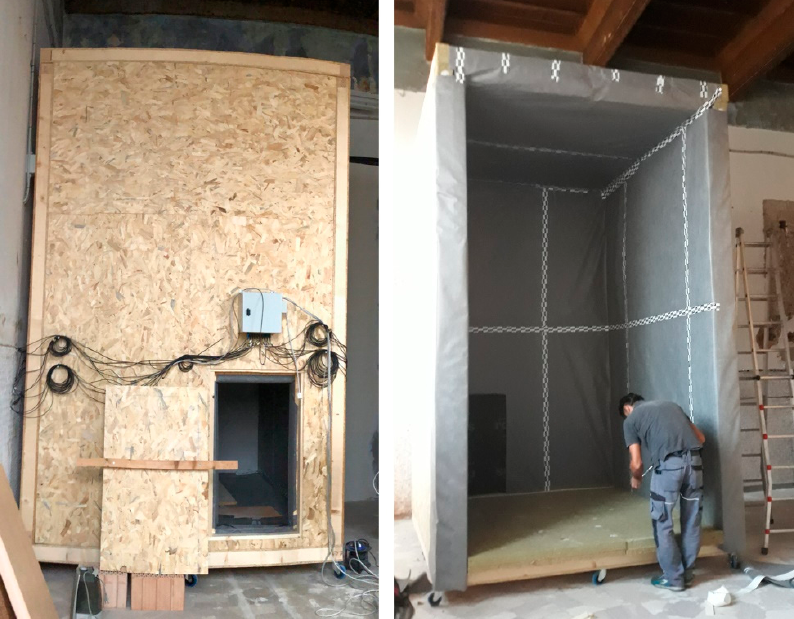
Figure 5. Box finishing: Thermal insulation and vapor barrier application.